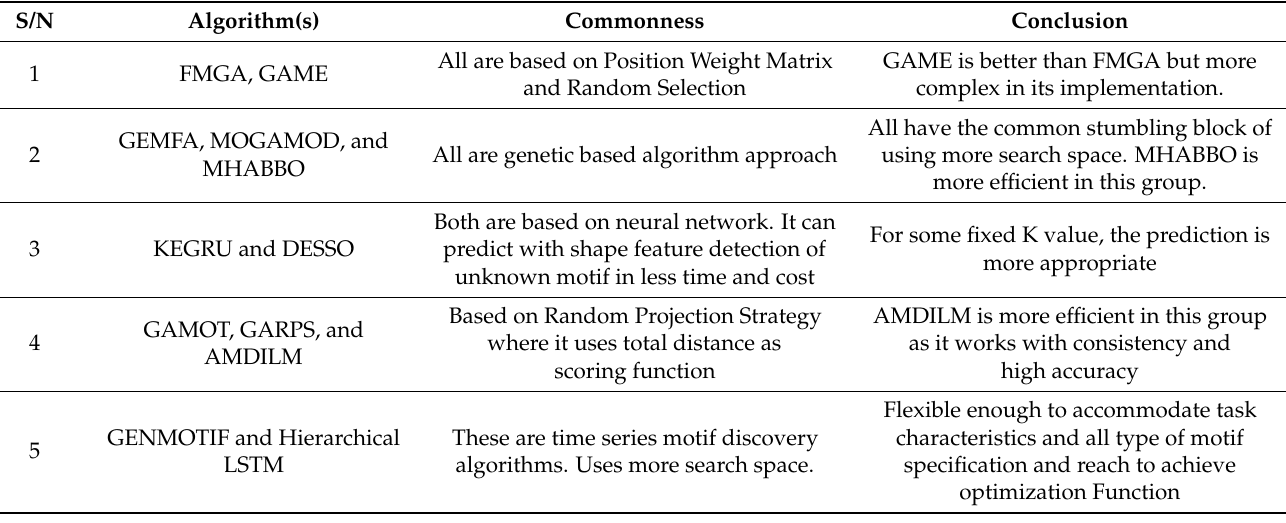
Table 3. Summary of Motif Discovery Algorithms based on Machine Learning